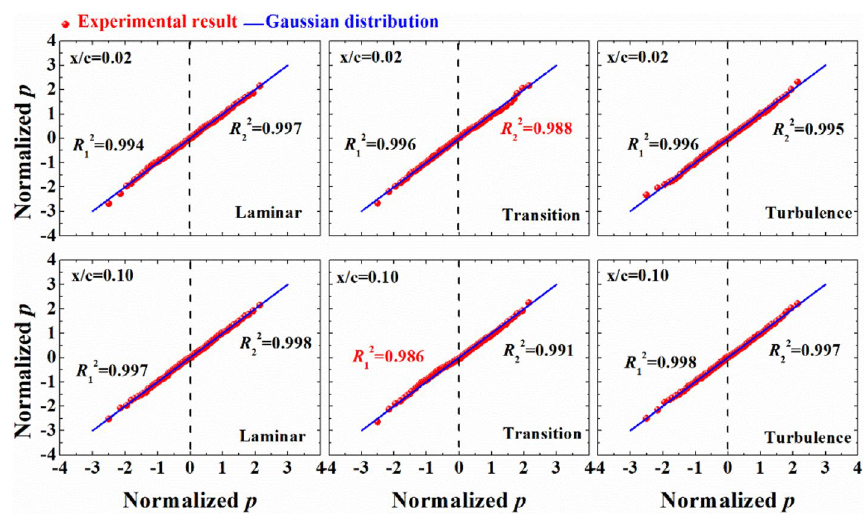
Fig. 5 Normal probability diagram at typical